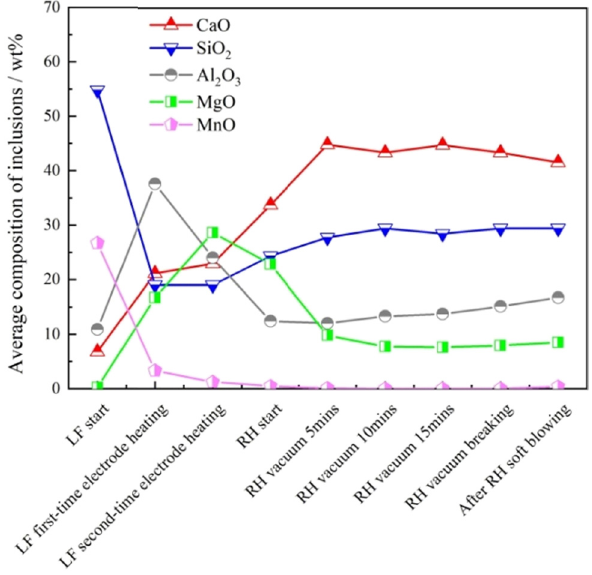
Figure 5: Evolution of the average composition of inclusions during the LF – RH re fi ning process in heavy rail steel.